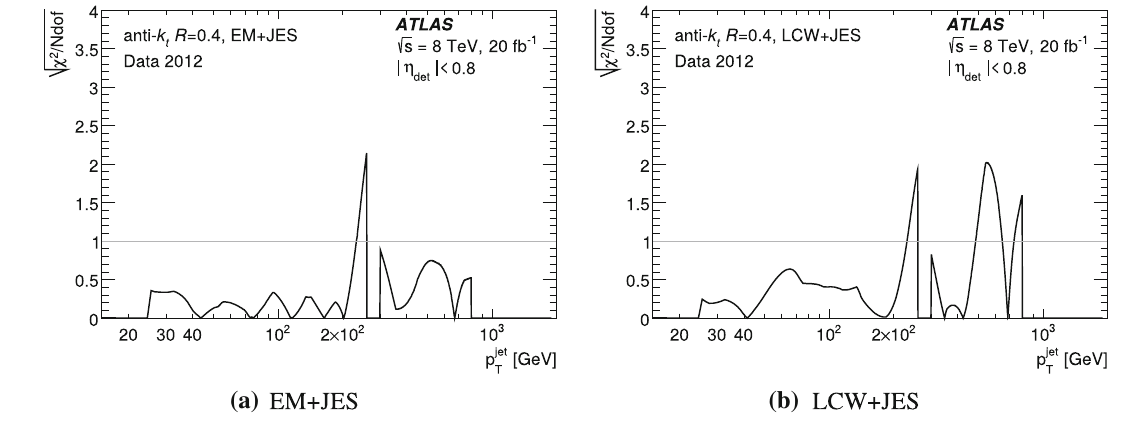
n dof is equal to one. For a small p T range near 300 GeV, only one measurement ( γ +jet) contributes, and there is a gap ( n dof = 0). The points where the curve touches zero correspond to where the two in situ calibrations